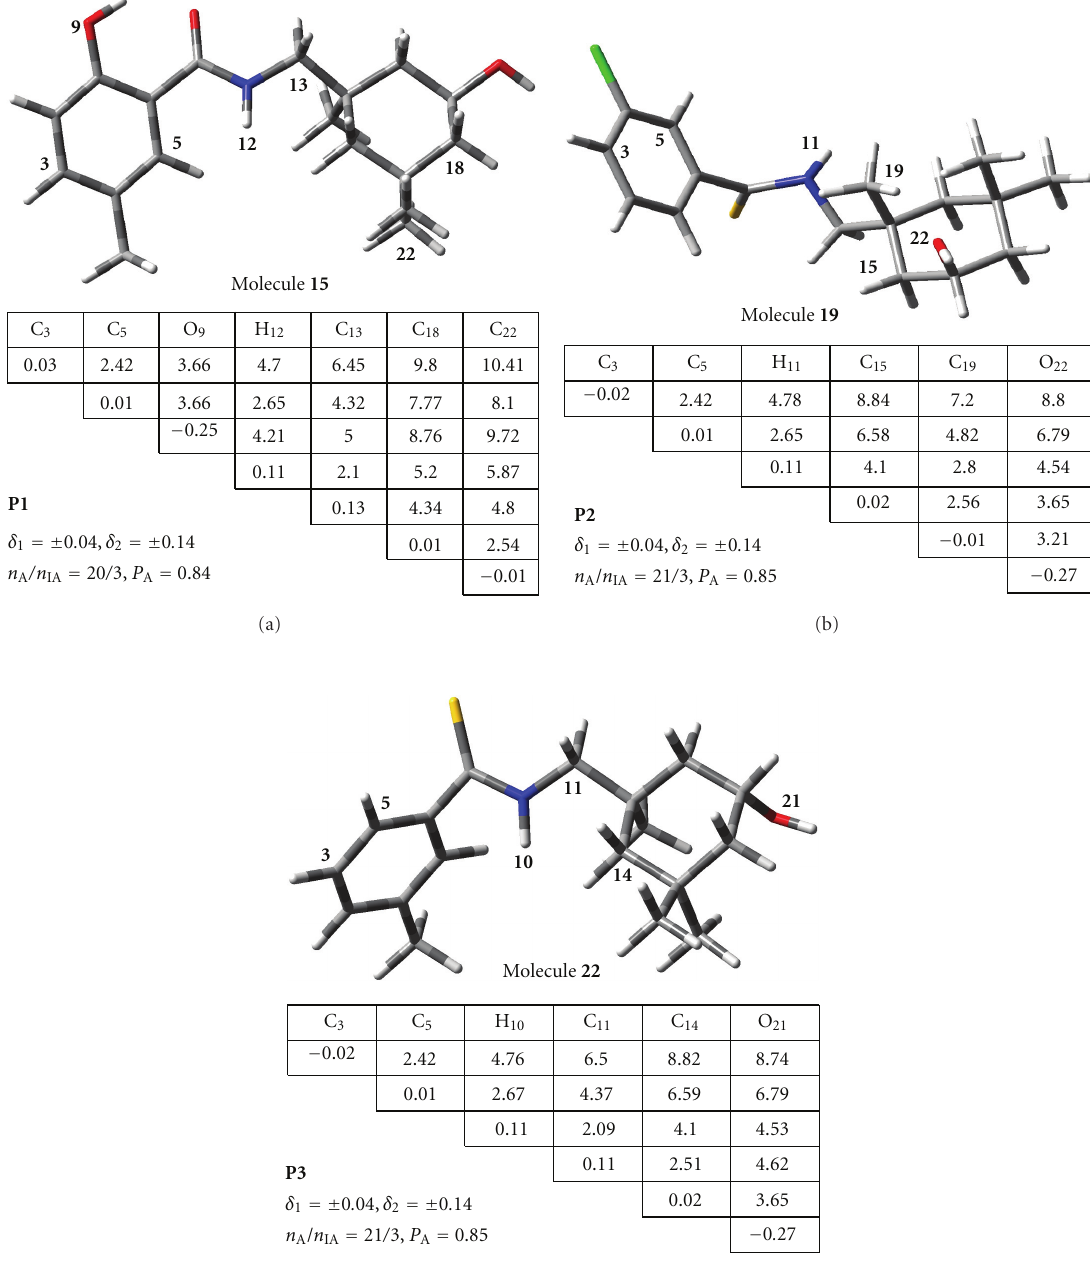
Figure 3: ETSC of the pharmacophores: P1 , P2, and P3 found relative to active molecule 15 , 19, and 22 .